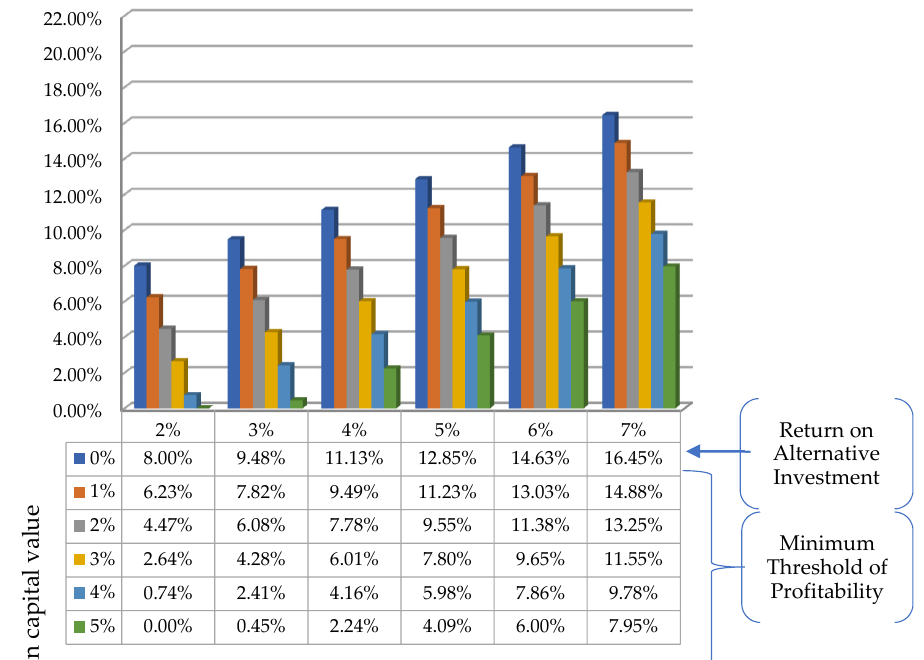
Figure 4. Distribution of the Pmt depending on the annual increase in capital value and return on alternative investment.